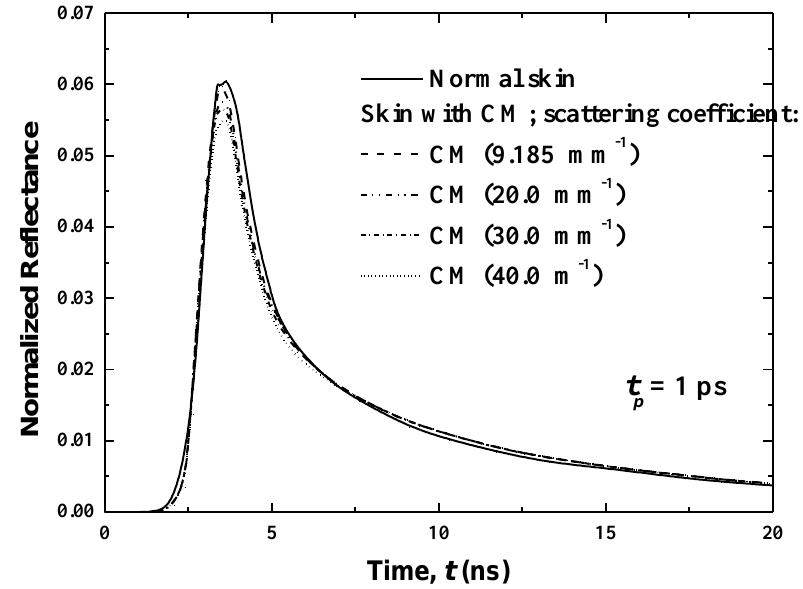
Figure 11. Effects of the scattering coefficient of the CM malignancy on the temporal reflectance signals.